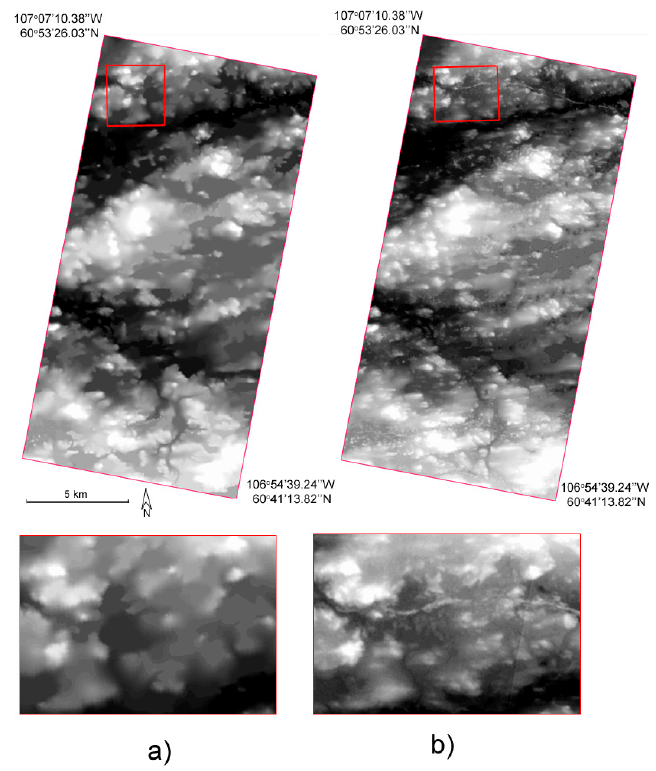
Figure 4. Examples of the two-digital elevation datasets used. The image ( a ) shows the Canadian Digital Elevation Data 1:50,000 scale rasterized to 30 m and image ( b ) shows the 8 m Arctic digital elevation model.